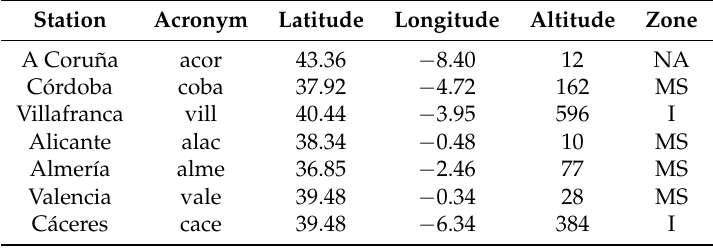
Table 1. Position of the GPS stations. Latitude and longitude are given in degrees north and east, while altitude is given in meters. Zones are: North atlantic (NA), Mediterranean Sea (MS) and interior (I). Station